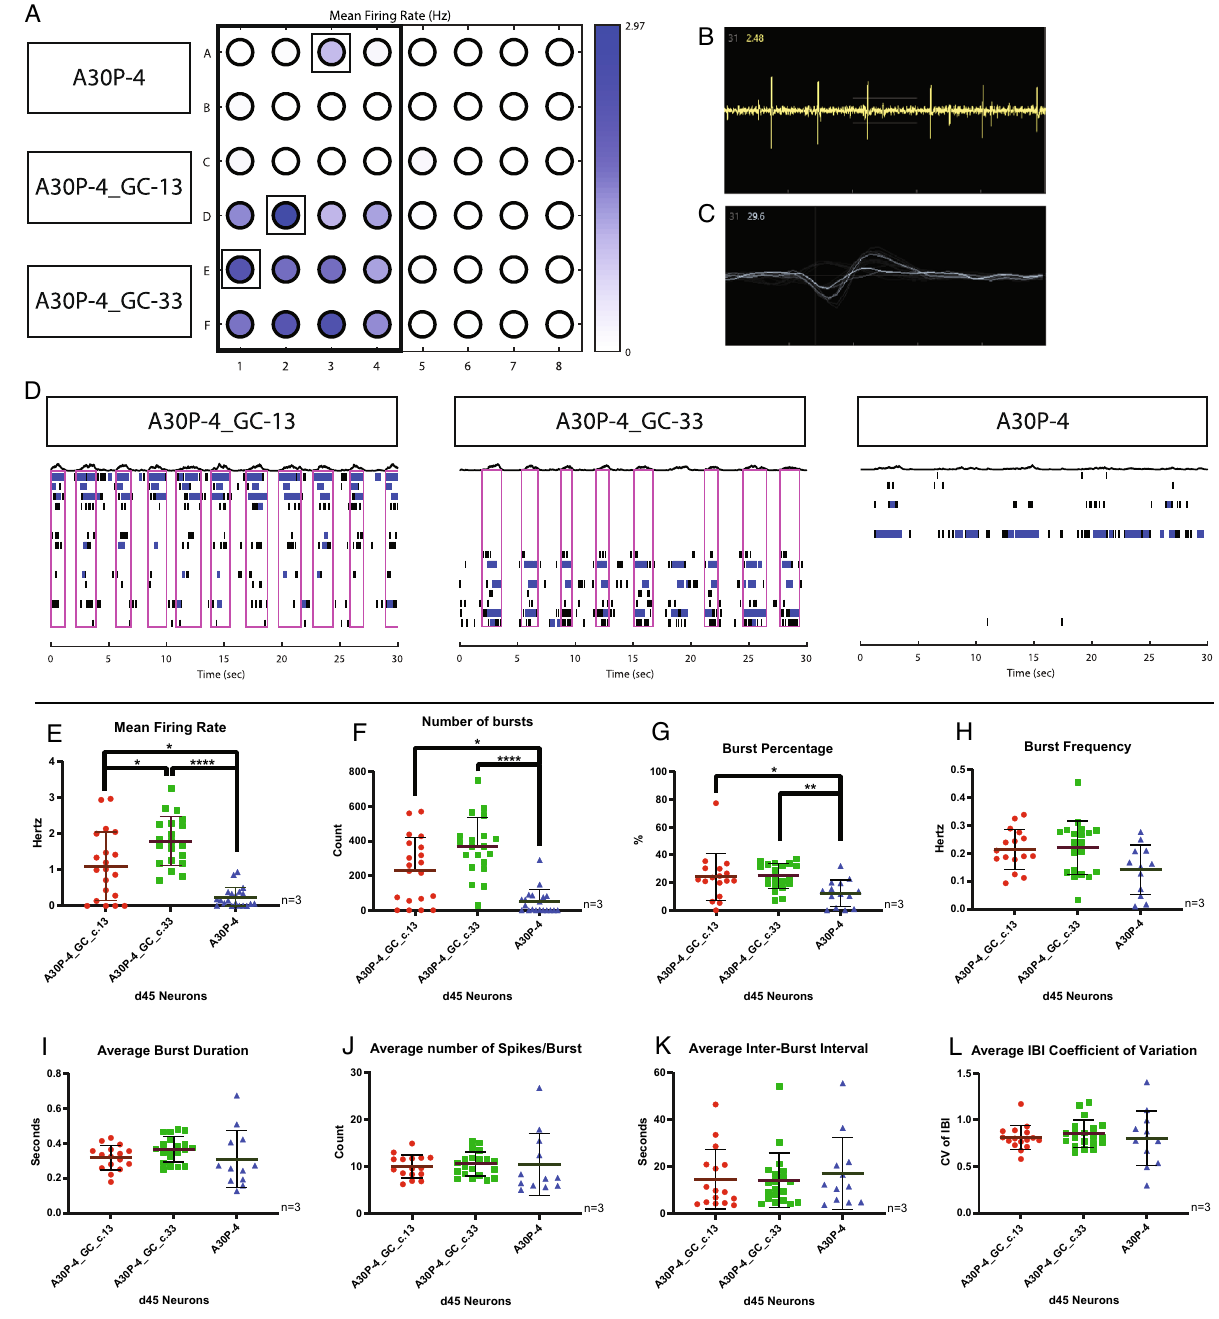
Figure 2. Multi-electrode array neuronal recording of d55 neurons. ( A ) Representative image showing the plate layout of recorded neurons with a heat map displaying the mean firing rate. ( B ) Representative example of a Waveform profile, ( C ) Representative example of a Spike plot, ( D ) Representative image of a raster plot profile, taken from the well highlighted in ( A ). Spike and burst metric parameters identified from the MEA recording: ( E ) Mean Firing Rate, ( F ) Number of Bursts, ( G ) Burst Percentage, ( H ) Burst Frequency, ( I ) Average Burst Duration, ( J ) Number of Spikes/Burst, ( K ) Average Inter-Burst Interval, and ( L ) Average Inter-Burst Interval (IBI) Co-efficient of Variation. Three biological replicates were used in the analysis with a minimum of six technical replicates per recording. The graphs displayed in columns show individual values that refer to the average data of each well, with each well composed of 16 electrodes. For all statistical analyses, a non-parametric Kruskal–Wallis test was performed using the Dunn’s post hoc multiple comparison test. All graphs were plotted as mean ± SD. *p < 0.05, **p < 0.01, ****p <